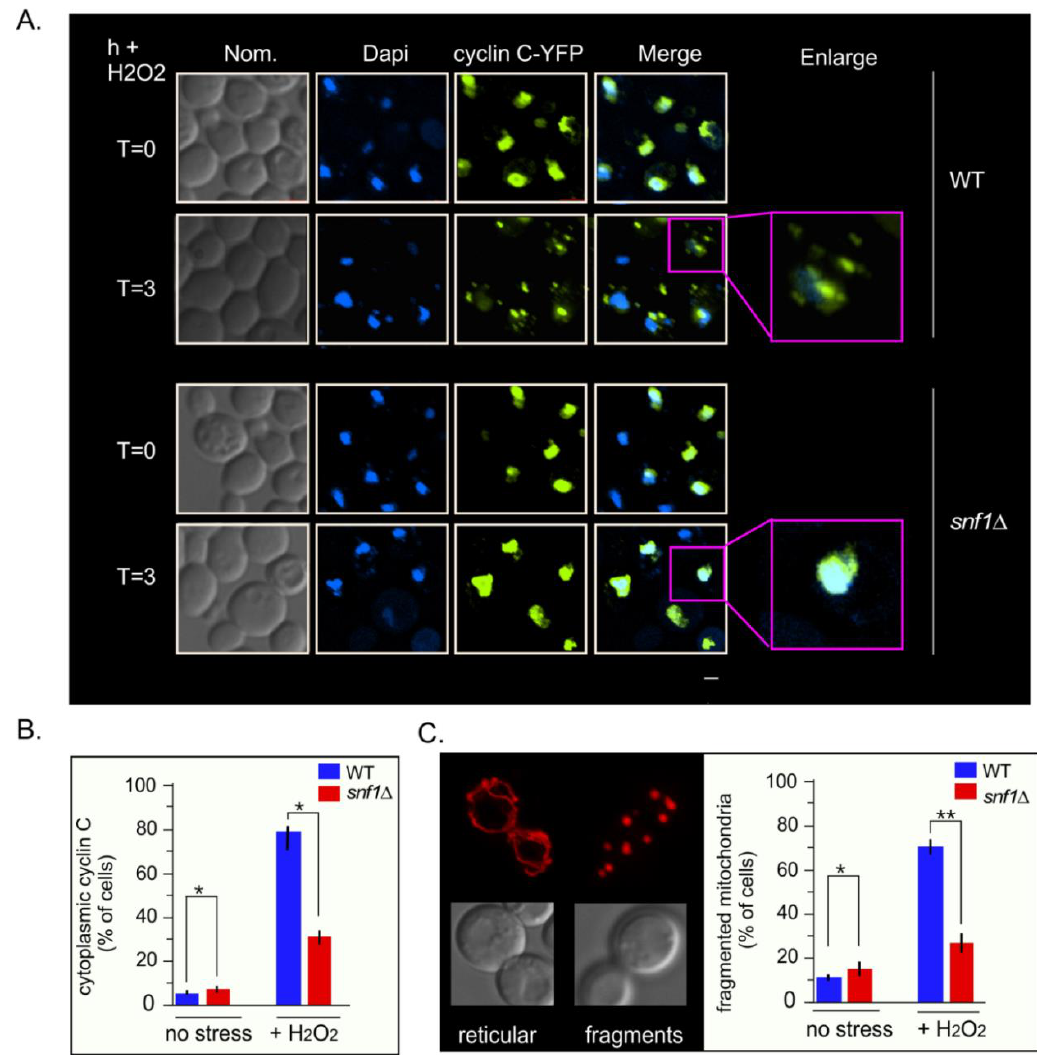
FIGURE 7: Cyclin C remains predominantly nuclear following H 2 O 2 stress in snf1 ∆ . (A) Fluorescence microscopy of mid-log phase wild-type and snf1 ∆ cells harboring a cyclin C-YFP expression plasmid (pBK38). Cells were stained with Dapi to visualize the nucleus. (B) Quantifica- tion of the results obtained in (A). At least 200 cells were counted per timepoint from 3 individual isolates. The percent of cells (mean ± SEM) within the population displaying cytoplasmic cyclin C is given. * p<0.05 difference from wild type. (C) Right panel: representative images of the two mitochondrial morphologies scored. Left panel: as in (B) except that percent of cells displaying fragmented mitochondria was scored. Representative images of the mitochondrial morphologies scored are shown in the left hand panel. The percent of cells (mean ± s.e.m.) within the population displaying fragmented mitochondria is given. * p<0.05 difference from wild type. ** p<0.01 difference from wild type. Bar = 13